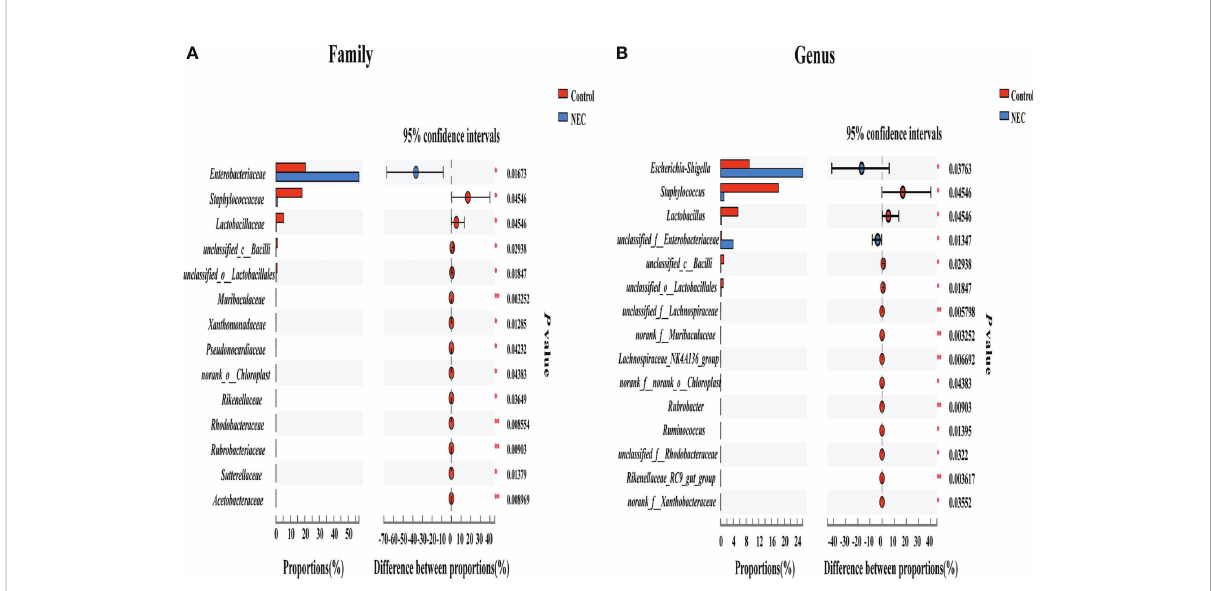
FIGURE 3 Comparison of fecal fl ora between NEC patient non-NEC patients. Differences between the control group and the NEC group at the (A) family and (B) genus levels using the Wilcoxon signed-rank test. Signi fi cant differences are shown by * P < 0.05, ** P <